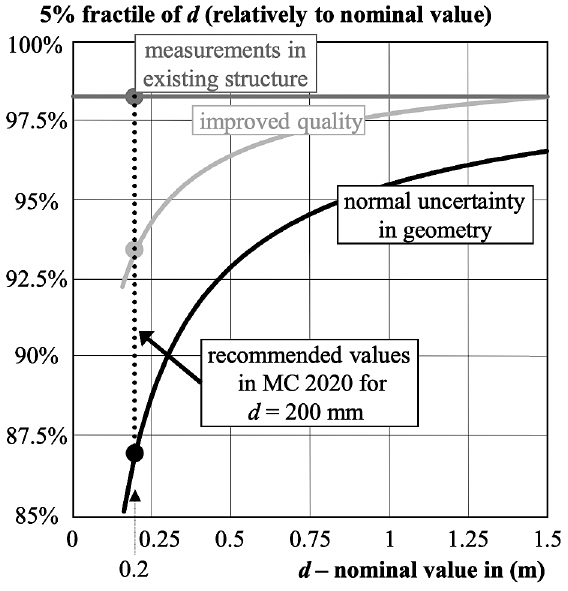
Figure 2. Effective depth - 5% fractiles as a function of nominal